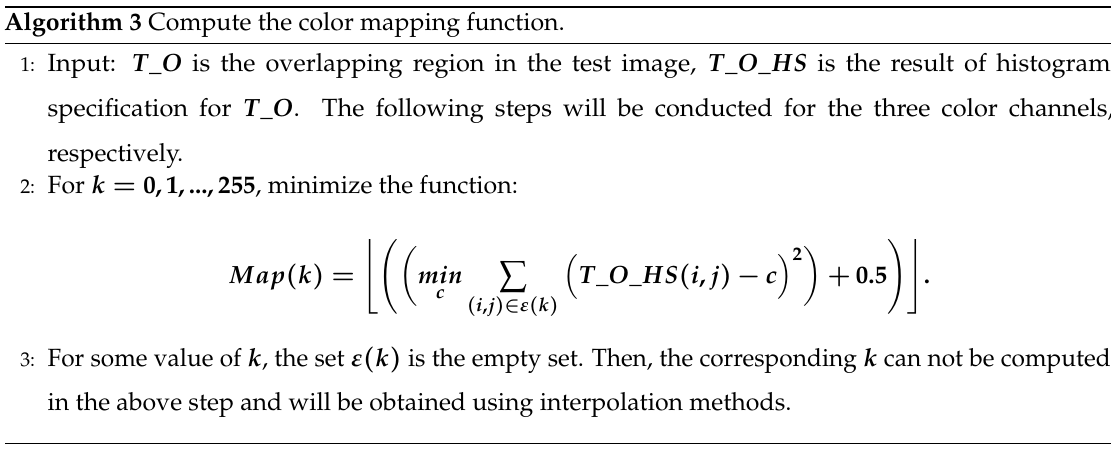
Algorithm 3 Compute the color mapping